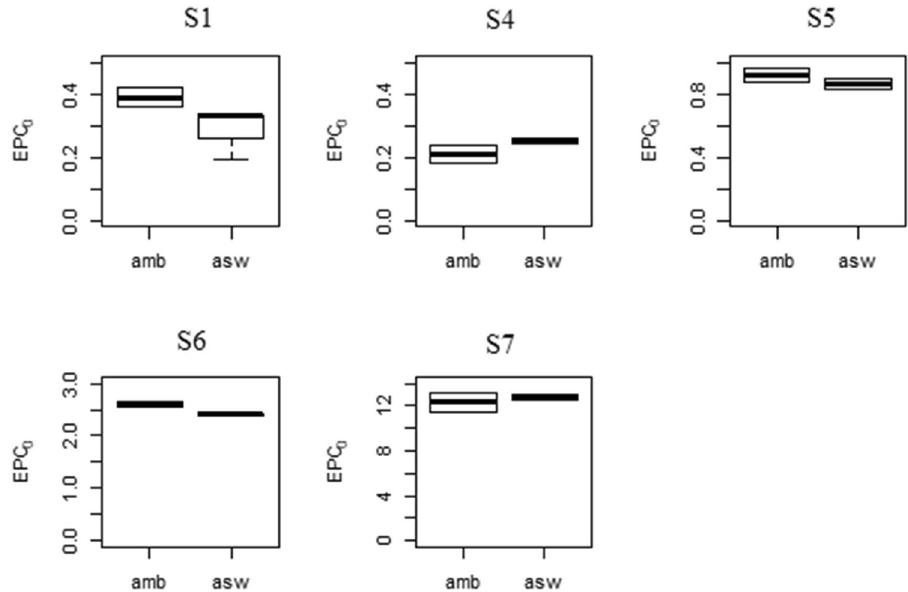
Fig. 5 Equilibrium P concen- trations at zero net P sorption (EPC ) values of sediments S1 0 and S4 − S7 equilibrated in ambient water (amb) and arti- ficial seawater (ASW). Note the different scales on the